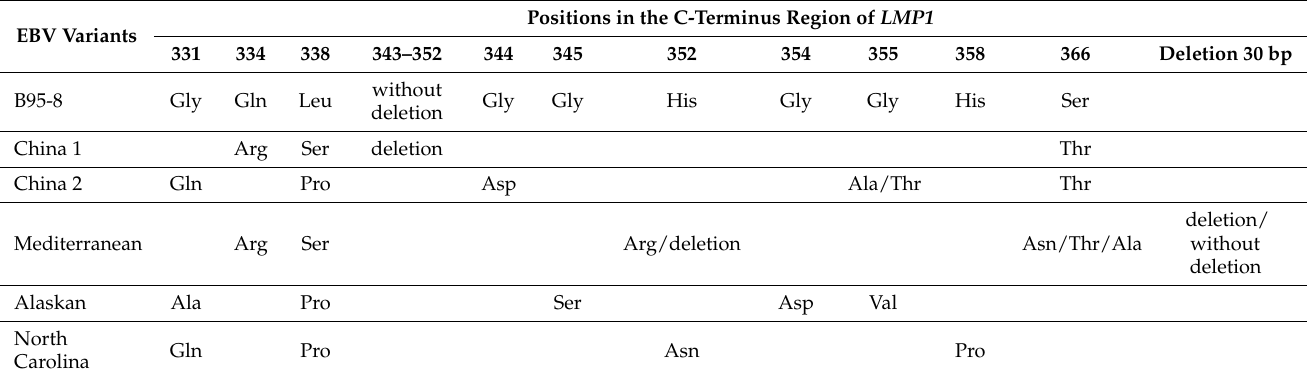
Table 3. An algorithm for EBV LMP1 variant